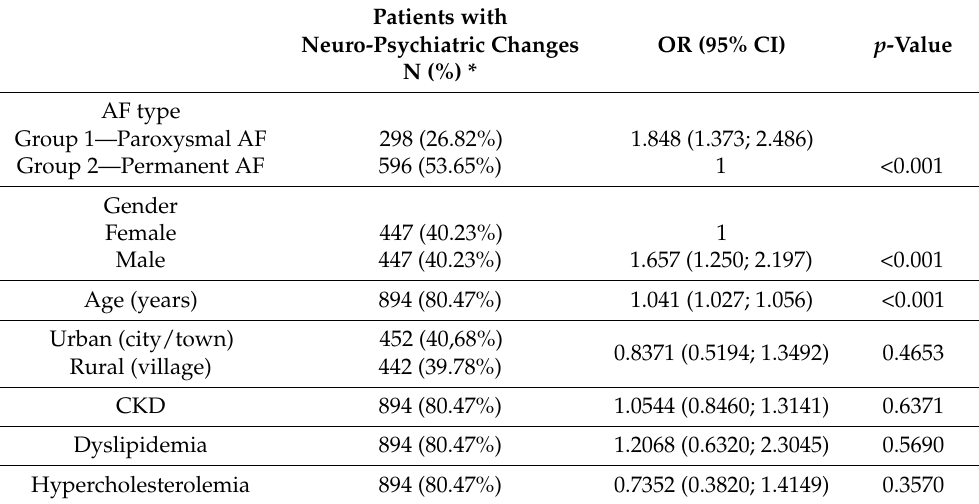
Table 6. Multiple logistic regression analysis for risk of neuro-psychiatric changes after AF diagnosis for AF type, gender, and age.